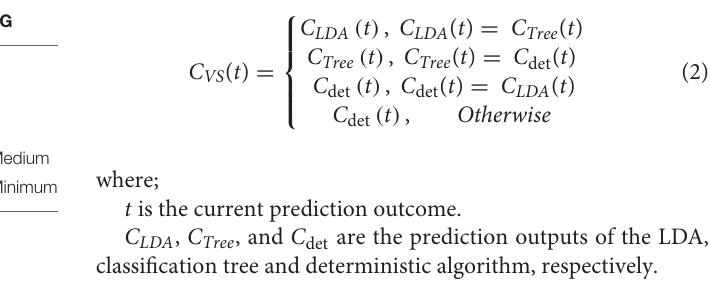
TABLE 1 | Muscle activation expectations of the deterministic algorithm. Movement